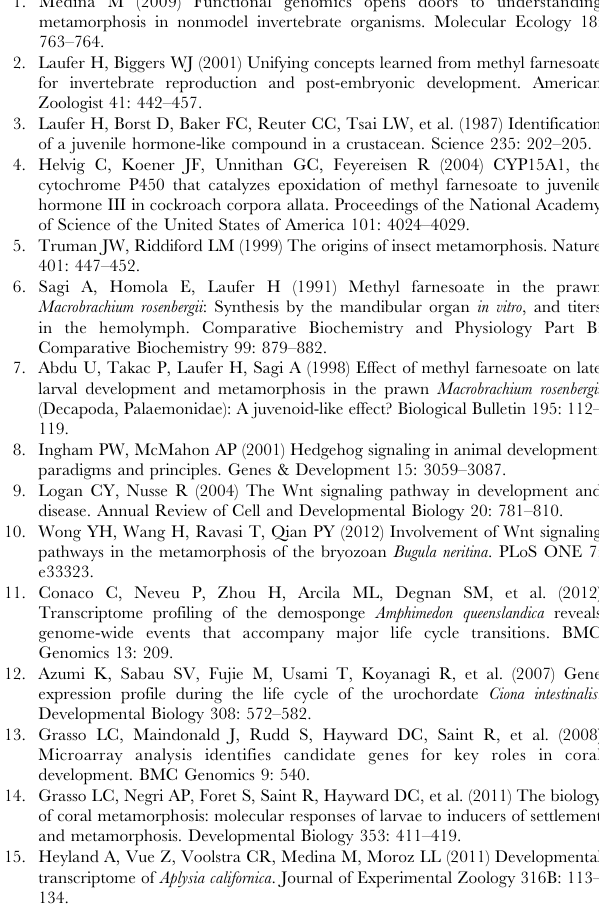
Figure S1 Transcriptome profile. Distribution of contigs length (A) and normalized coverage (B). Figure S2 Gene Ontology (GO) annotations according to sequence. A list of all GO terms according to Blast2GO is given for all sequences which had at least one BLASTX hit with an e- value , 10 2 5 , an alignment length $ 100 amino acids and an alignment region cover . 50% of the transcript length (the 13,126 termed Annotated transcripts ). The full list is followed by smaller sub- lists according to biological processes, molecular functions and cellular components. Figure S3 Lists of contigs with . 100-fold change over- expression in Larvae and PLs. Contig list was filtered to include transcripts with at least 500 bp and redundant transcripts of the same locus were not included.